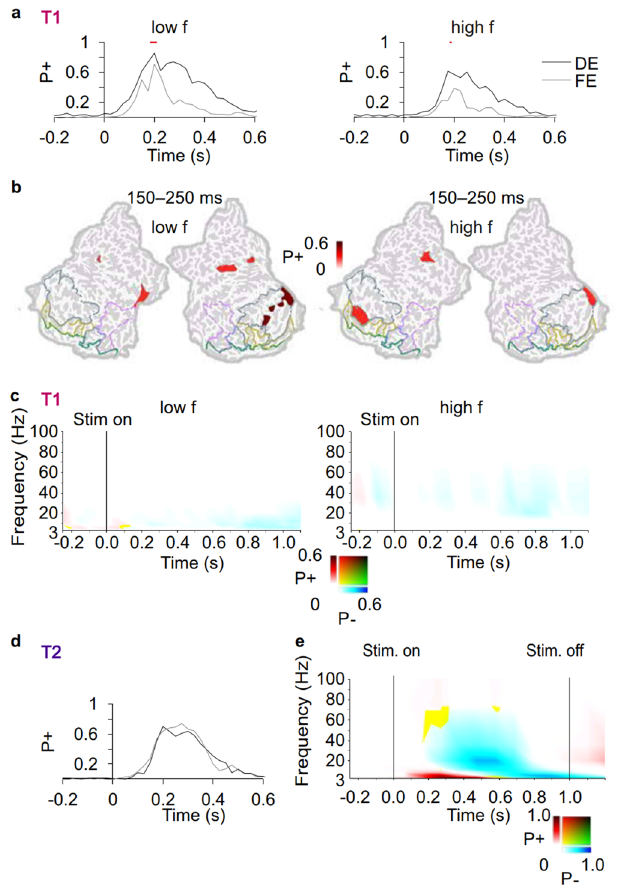
Figure 5. Neuronal processing is not facilitated for the FE compared to control subjects. ( a ) The fraction of parcels in which ER showed significant modulation compared to baseline for DE of the control subjects and the FE of the patients ( t- test, p < 0.05, FDR corrected) in T1. The red lines indicate statistical differences between DE and FE (Welch’s t -test, p < 0.05, FDR corrected). ( b ) Cortical locations of the ER differences between DE and FE. ( c ) Oscillation amplitude differences between DE and FE in T1 (Welch’s t -test, p < 0.05, FDR corrected). ( d ) Same as a but for T2. ( e ) Same as c but for